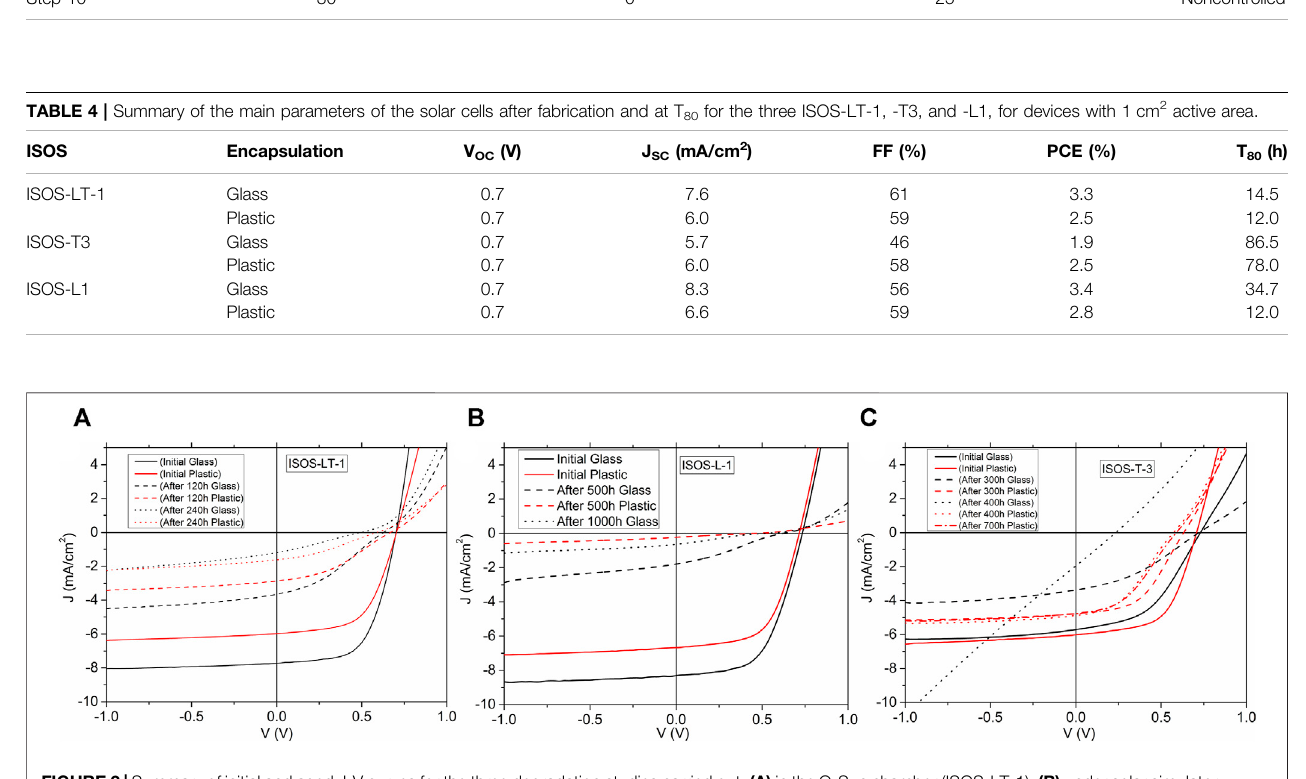
Frontiers in Energy Research |